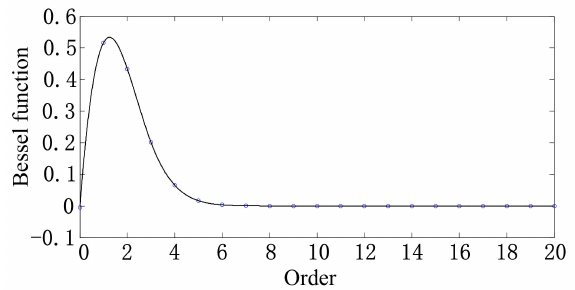
Figure 7. The fitting curve of the Bessel